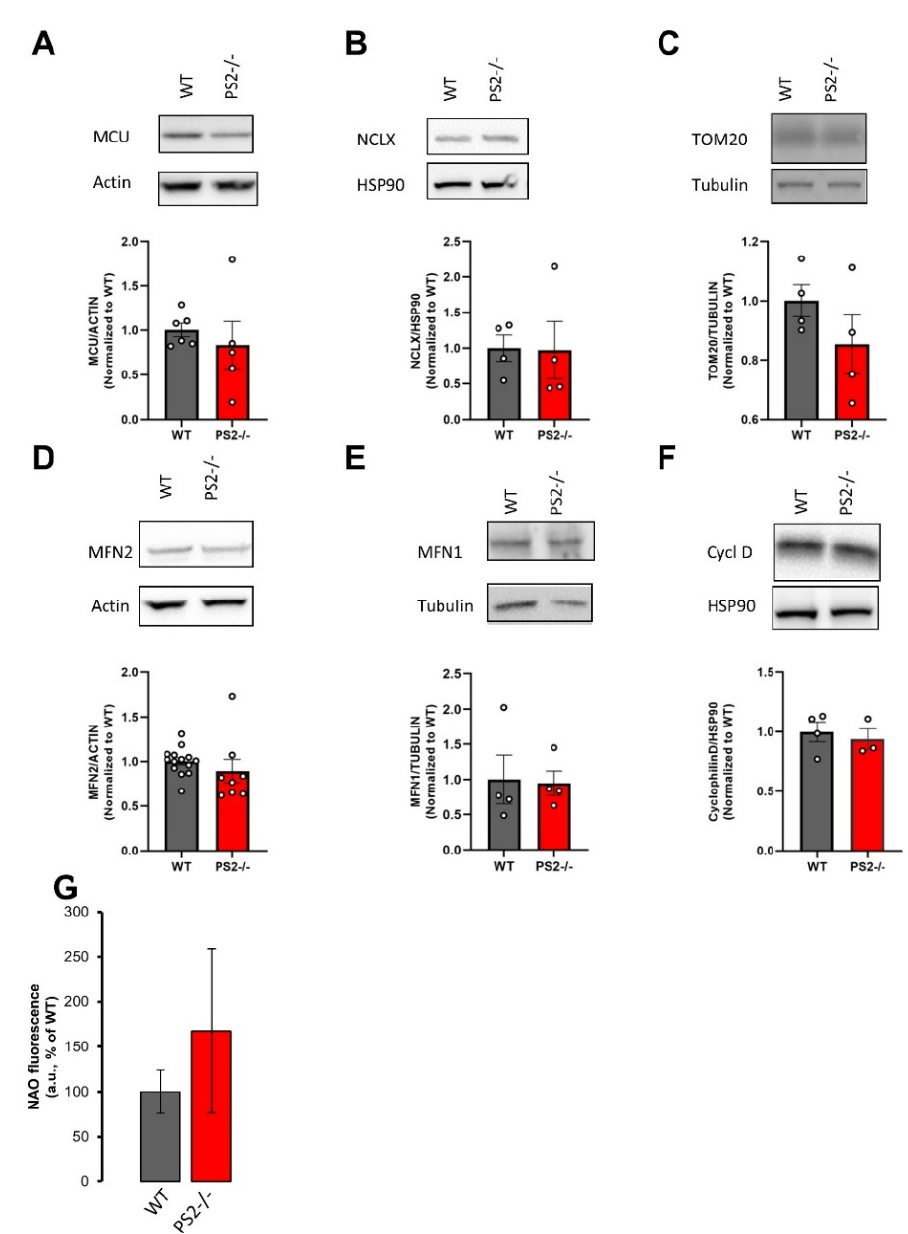
Figure 3. The lack of PS2 does not affect the mitochondrial mass. Representative Western blots of different mitochondrial protein levels in WT and PS2–/– cortical neurons. Each sample was run in duplicate. The corresponding scatter plot represents the mean values ± SEM. Values were first nor- malized to their internal housekeeping proteins (as indicated) and then to those of WT samples. ( A – G ) Representative Western blot and quantification of: ( A ) mitochondrial Ca 2+ uniporter (MCU) pro- tein levels of 6 independent cultures from WT mice and 5 independent cultures from PS2–/– mice; ( B ) NCLX protein levels of 4 independent cultures from WT mice and from PS2–/– mice; ( C ) TOM20 protein levels of 4 independent cultures from WT mice and from PS2–/– mice; ( D ) MFN2 protein levels of 14 independent cultures from WT mice and 8 independent cultures from PS2–/– mice; ( E ) MFN1 protein levels of 4 independent cultures from WT mice and from PS2–/– mice; ( F ) cyclophilin D (cycl D) protein levels of 4 independent cultures from WT mice and 3 independent cultures from PS2–/– mice. ( G ) The bar graph shows the mean values ± SEM of Nonyl Acridine Orange (NAO) fluorescence (arbitrary units) from 4 independent cultures from WT mice and 3 independent cul- tures from PS2–/– mice, as a percentage of WT. Moreover, mitochondrial mass was further estimated by cardiolipin staining com- bined with flow cytometry quantification [17]. As shown in Figure 3G, no significant dif- ferences in this parameter were detected between WT and PS2–/– cortical neurons. Taken together, these results indicate that neither mitochondrial mass nor organelle morphology are modified by the lack of PS2 expression.